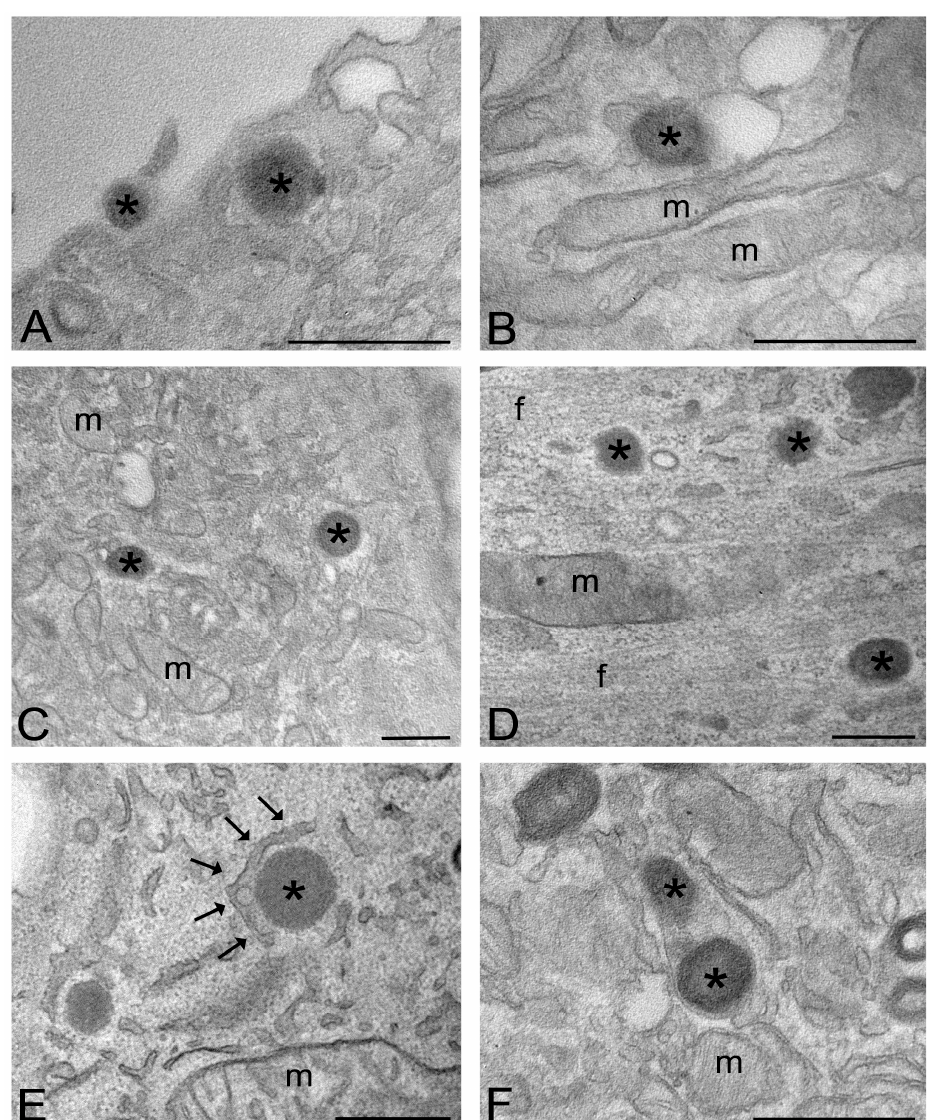
Figure 5. TEM micrographs of myoblasts ( A – C , F ) and myotubes ( D , E ) after 2 h ( A , B ) and 24 h ( C – F ) incubation with 5% SC-nanoparticles, respectively. ( A ) Two nanoparticles (asterisks) are entering the cell by endocytosis. ( B ) A nanoparticle (asterisk) is escaping an endosome. ( C , D ) Nanoparticles (asterisks) occur free in the cytosol. ( E ) A nanoparticle, occurring free in the cytosol (asterisk), is enclosed by double membranes (arrows) undergoing autophagocytosis. ( F ) Two nanoparticles (asterisks) inside a secondary lysosome. m, mitochondria; f, myofibril bundles. Bars, 200 nm.